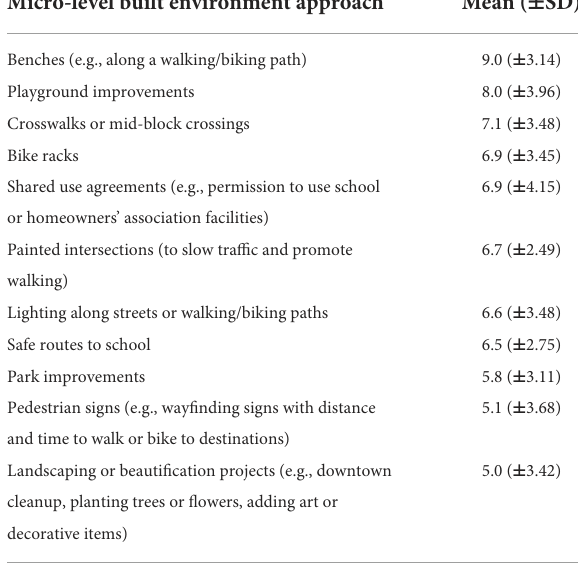
TABLE 1 Ranked order of desired built environment